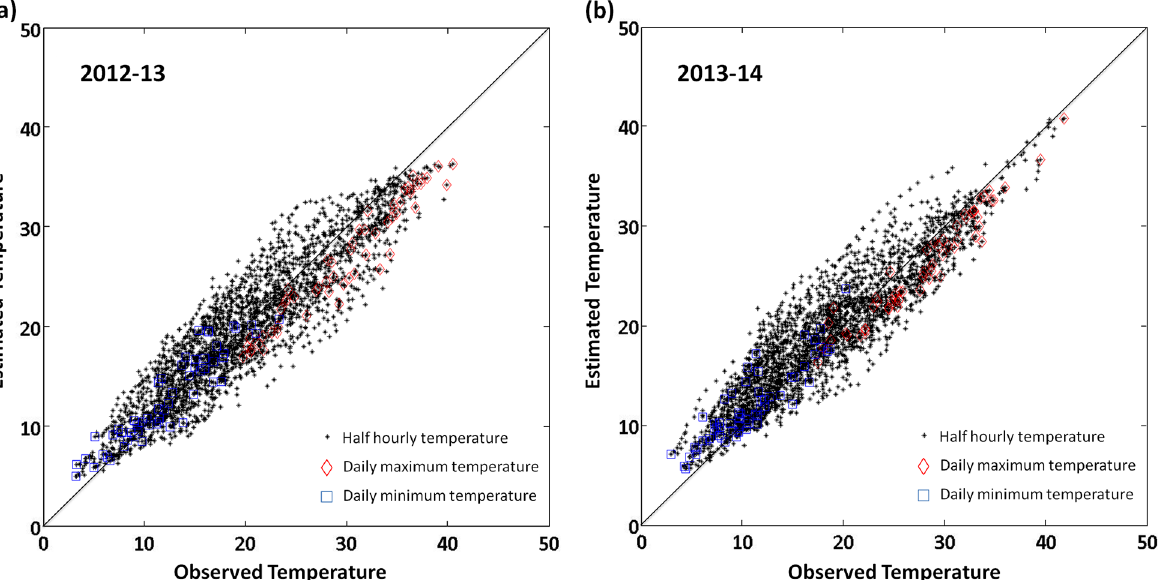
Fig 3. Validation of simulated temperature model. A linear regression is established between observed and estimated temperature for (a) 2012 – 13 growing season, from temperature data from artificially shaded temperature logger (L2013B), y = 0.8424x+3.383 (R 2 = 0.84, RMSE = 2.855, p < 0.0001); (b) 2013 – 14 growing season, using temperature data from artificially shaded temperature logger (L2014B), y = 0.8139x+4.228 (R 2 = 0.86, RMSE = 2.478, p < 0.0001). AWAP daily maximum and minimum temperature used in STM were illustrated in red and blue colour,